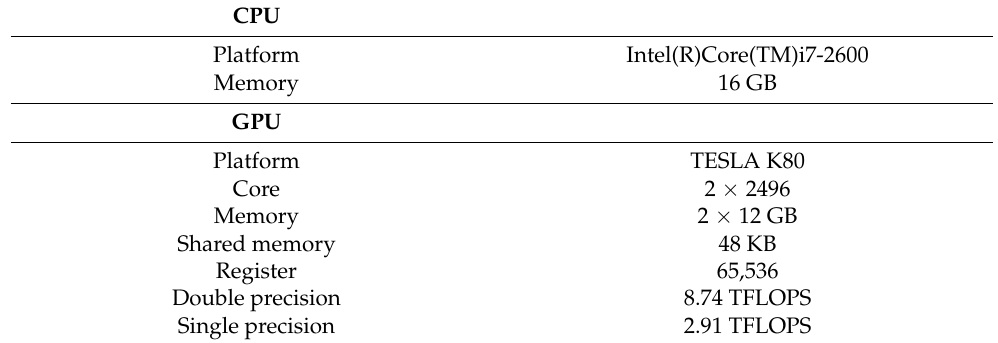
Table 3. Computing device platform configuration information.